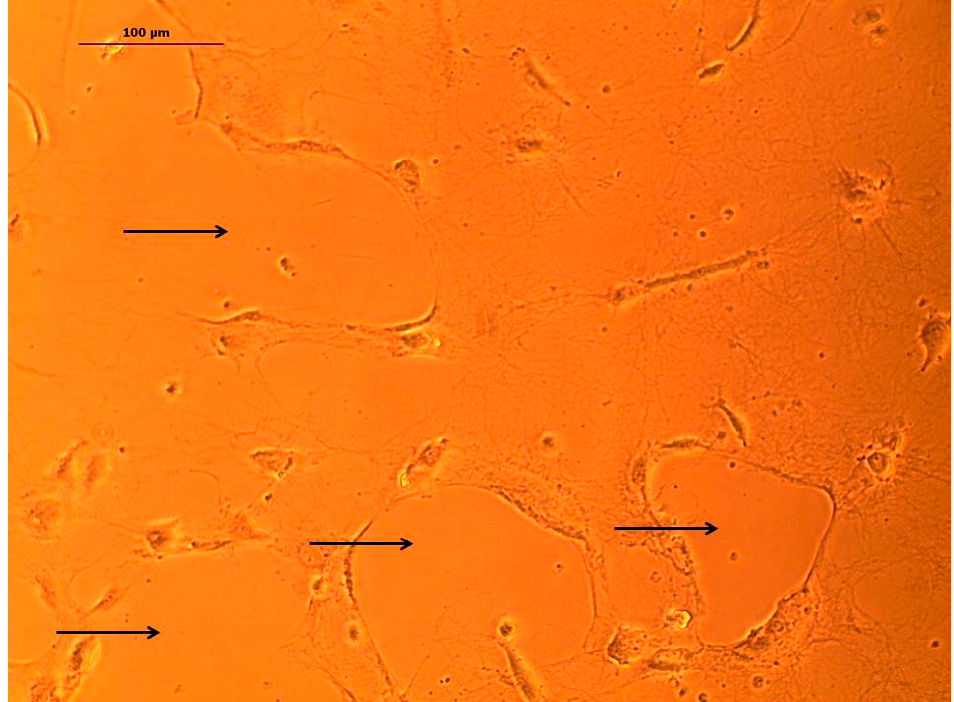
Figure A1. Example image of HPAEC endothelial cells disintegrating collagen coating after incubation time of 24 h. Within the culture, holes within the collagen layer can be observed (black arrows). Scale bar 100 µm.